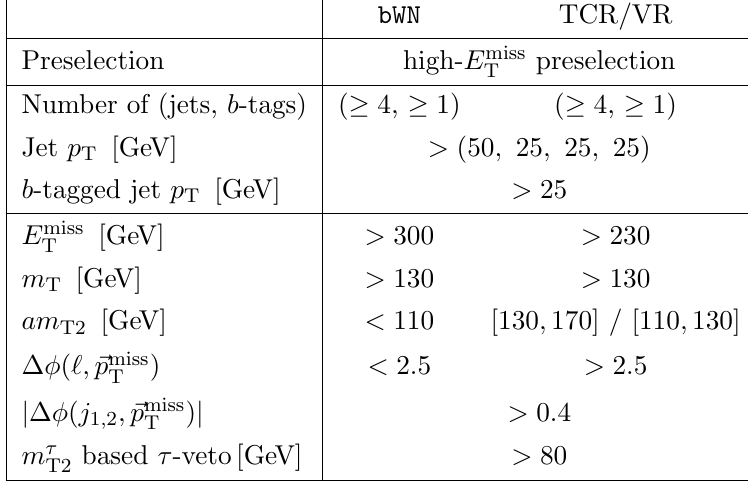
Table 17 . Overview of the selections for the bWN signal region and associated control and validation regions. List values are provided in between parentheses and square brackets denote